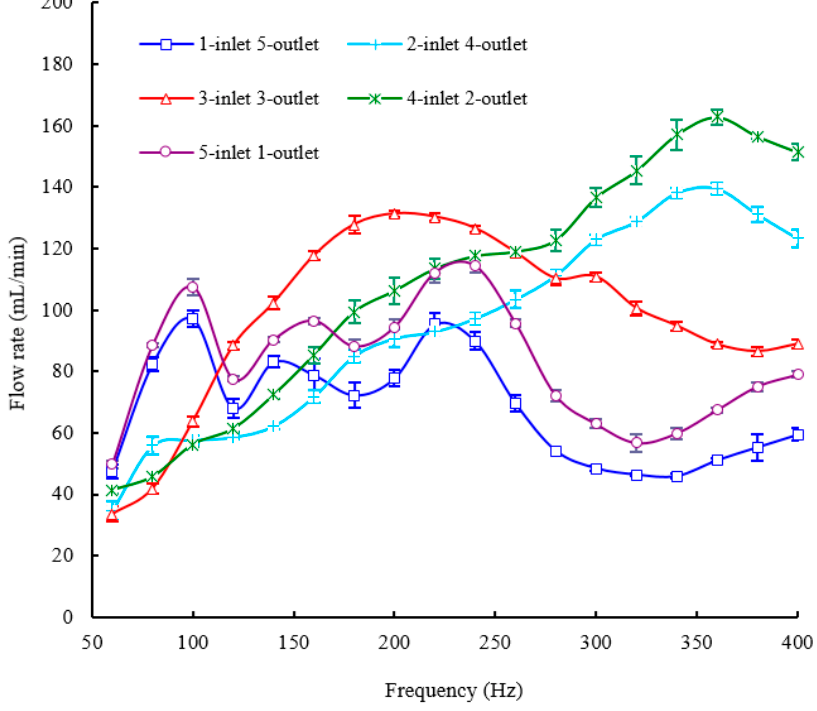
Figure 5. The flow rate versus frequency characteristics of the pump with different configurations of inlet valves and outlet valves.